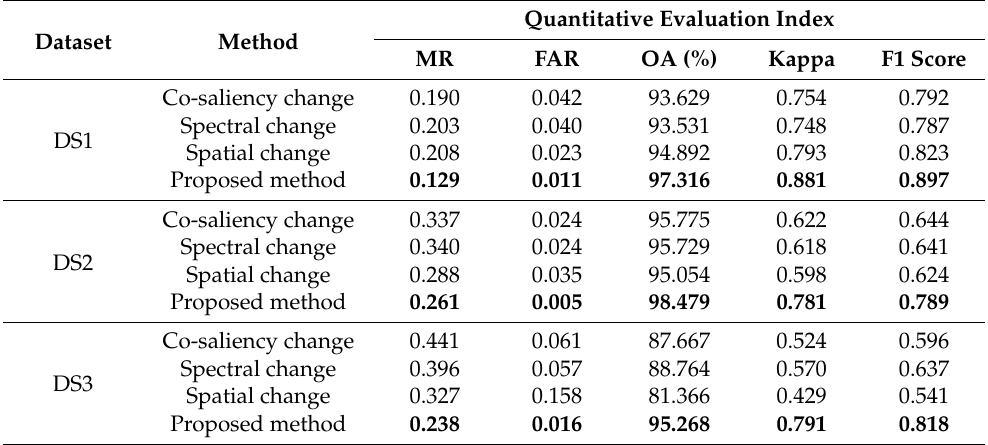
Table 2. Quantitative evaluation of change detection results in the first